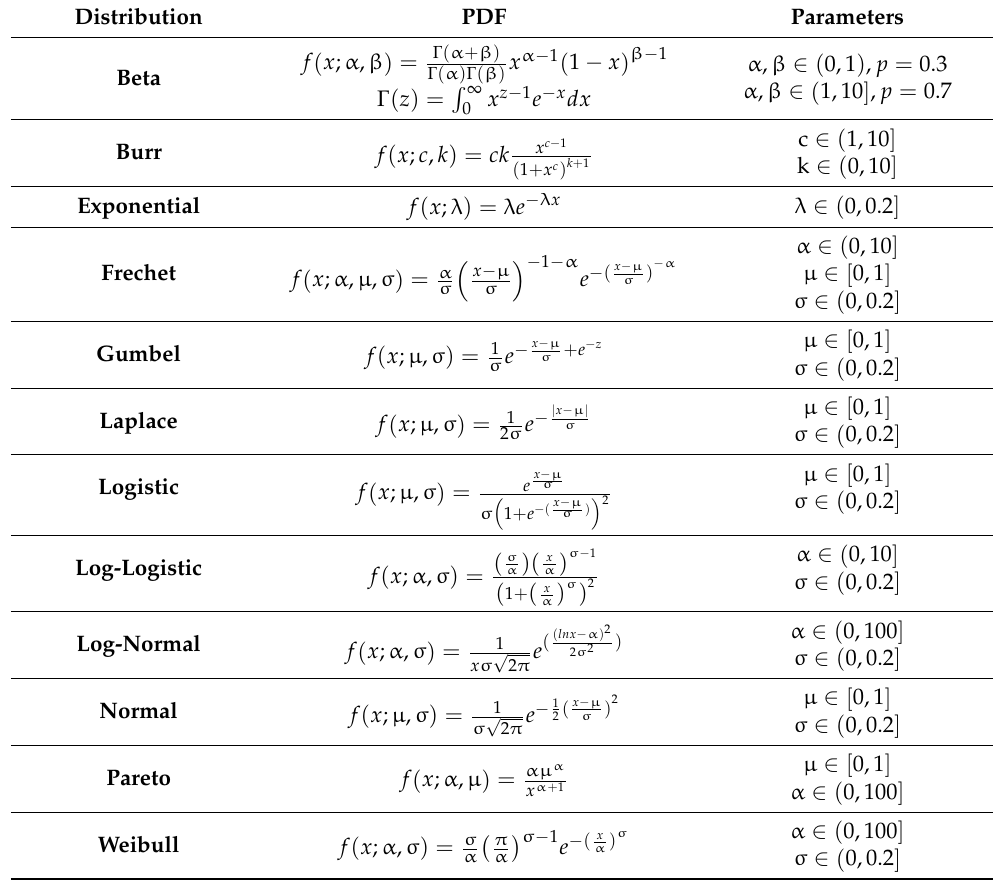
Table A2. Distributions used in creating the Synthetic dataset. Distribution PDF